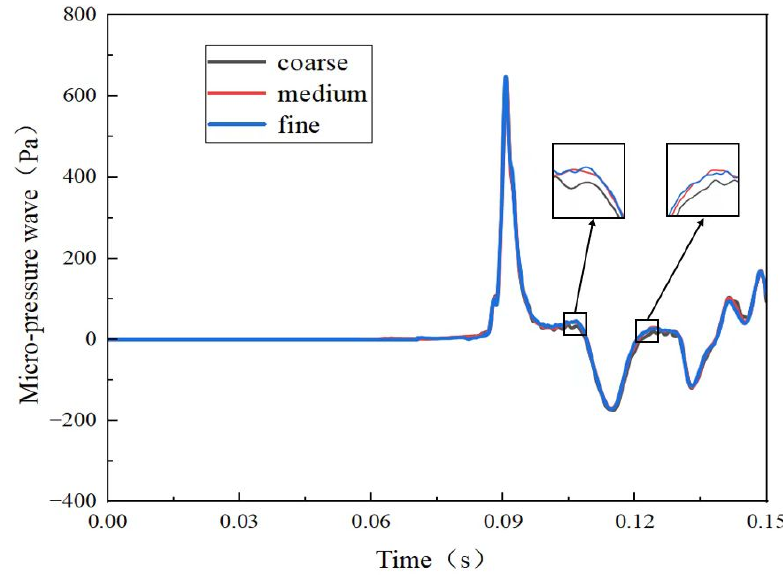
Figure 6. Micro-pressure waves at the tunnel exit for three grid densities with respect to